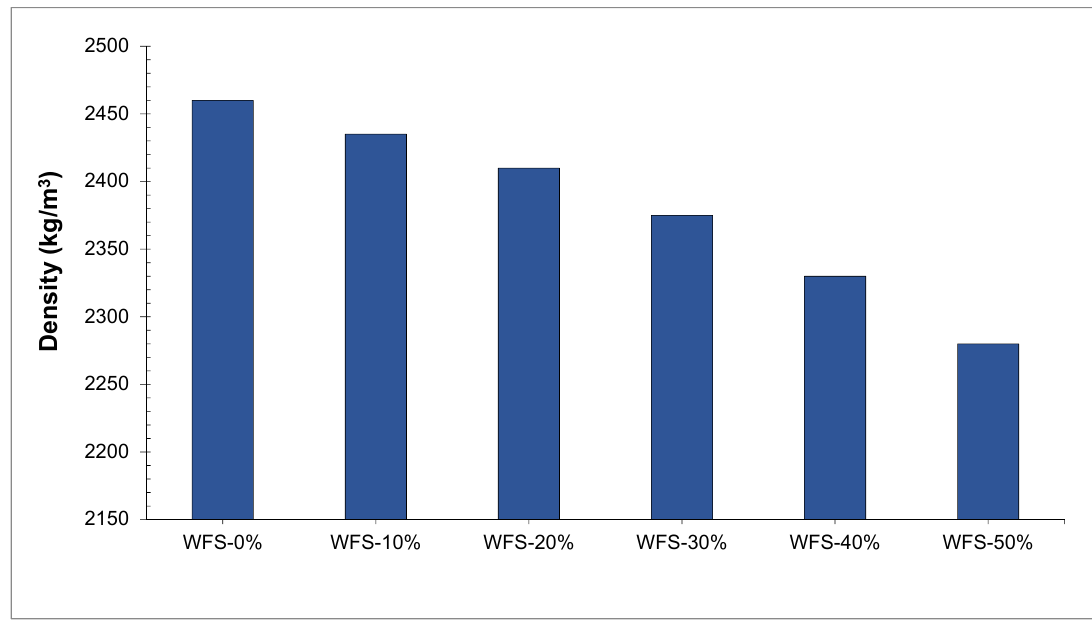
Figure 10. Density of concrete [39].